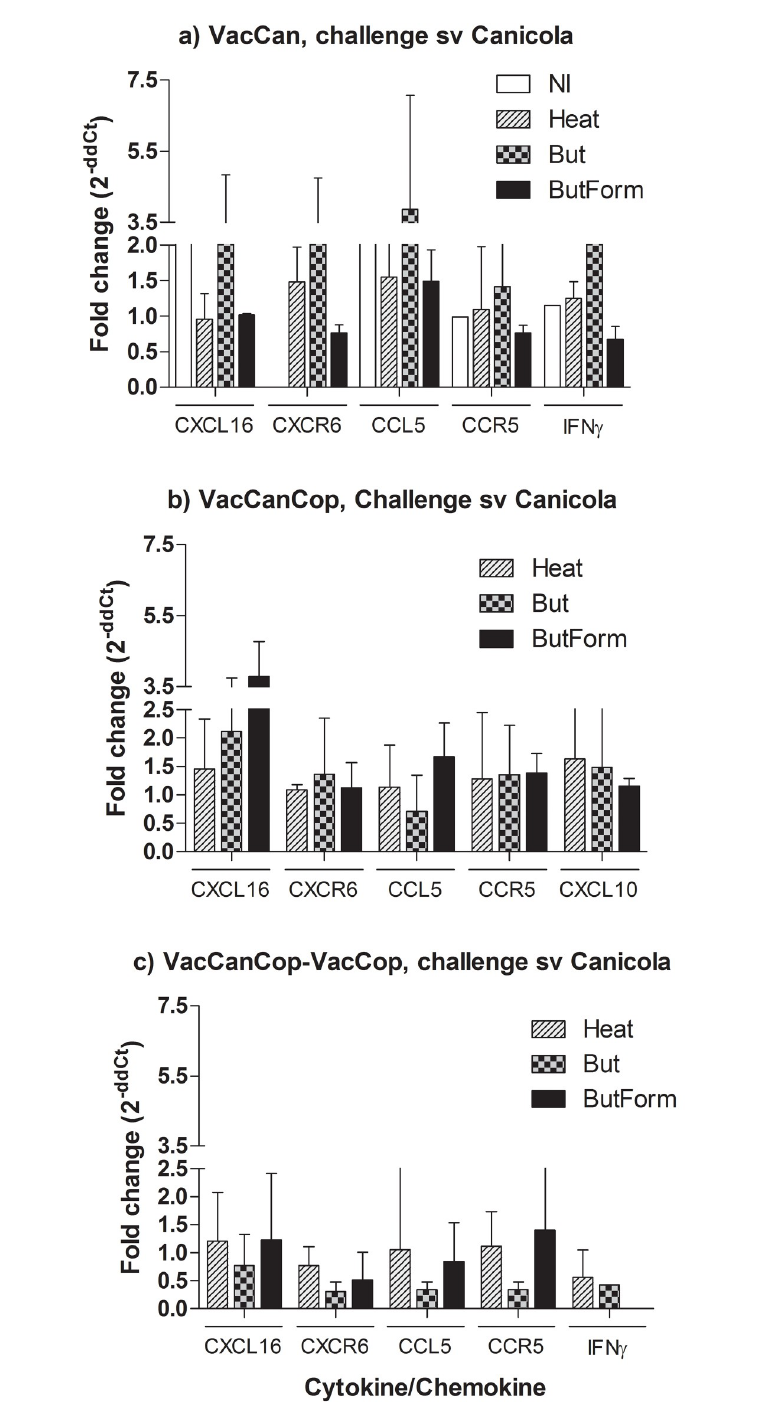
Fig 3. Transcription levels of cytokines, chemokines and their receptors in kidney samples collected from hamsters immunized and challenged with L . interrogans sv Canicola. Analysis of samples ware performed in triplicates, and two independents experiments. Cycle threshold (C T ) values for specific genes were normalized to the C T values of chemokine genes with gapdh